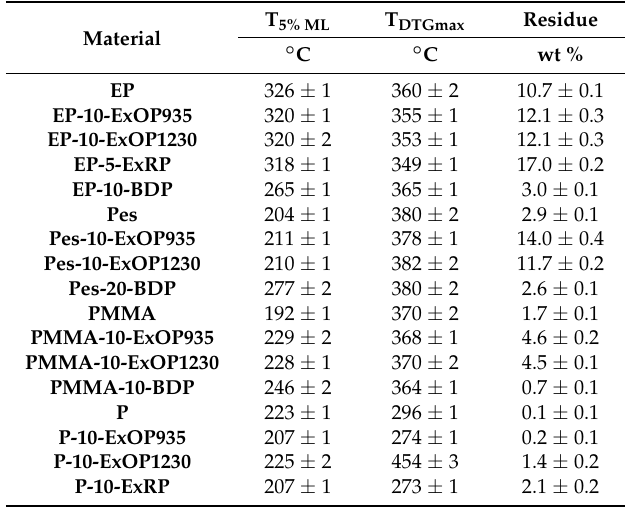
Table 2. Results from thermogravimetric analysis (TGA). T 5% ML is the temperature at which 5 wt % of the mass is lost, T DTGmax is the temperature of the maximum of the mass loss rate. The residue was determined at 800 ◦